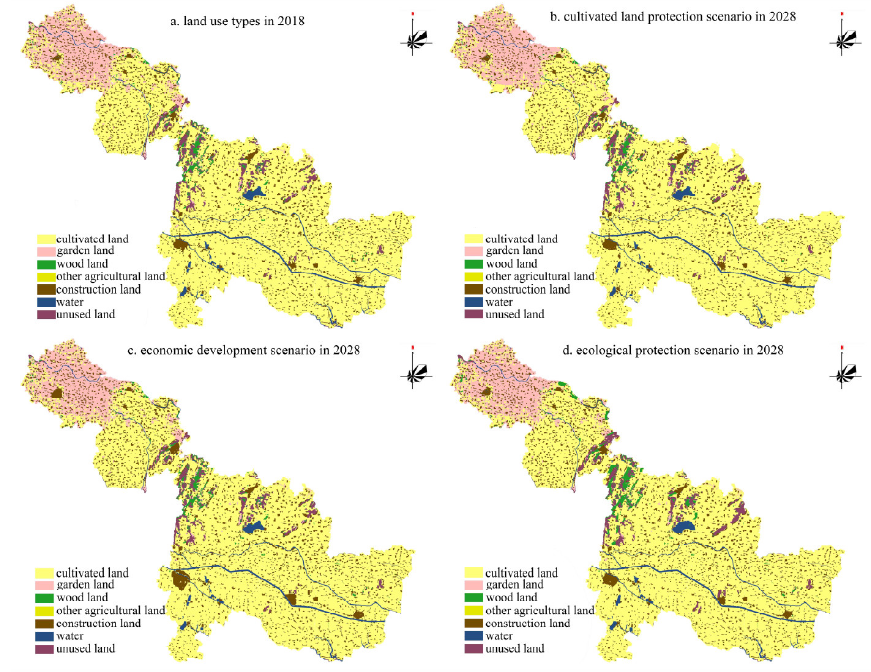
Figure 5. Land use map in 2018 and simulated results in 2028 under different scenarios. In order to compare the simulation results of the land use landscape pattern evolution under three scenarios in Suzhou City, the degree of polymerization (AI) and degree of spread (CONTAG) were selected to analyze the different characteristics of the land use landscape pattern in Suzhou City (Figure 6). The following is presented in Figure 6: ① the AI and CONTAG of the land use landscape pattern under the ecological protection scenario are the largest, which shows that the spatial aggregation of the land use landscape pattern under the scenario is the highest and its connectivity is the best. ② The spatial heterogeneity of the land use landscape pattern under the cultivated land protection scenario and economic development scenario are strong, indicating that the spatial distribution is relatively scattered. ③ In addition, collectively, ( Ⅰ) cultivated protection scenario, ( Ⅱ) economic development scenario, and ( Ⅲ) ecological protection scenario show that there is a high similarity between the simulated regional land use pattern spatial evolution under the economic development scenarios and the general land use planning map of Suzhou; it shows that the future of Suzhou City is in the accelerated period of urbanization development. Therefore, it is necessary to make reasonable and scientific planning for future land use in Suzhou City, not only to promote regional economic development, but also to ensure sustainable land use, which is the focus of the land resource management policy in Suzhou City for the